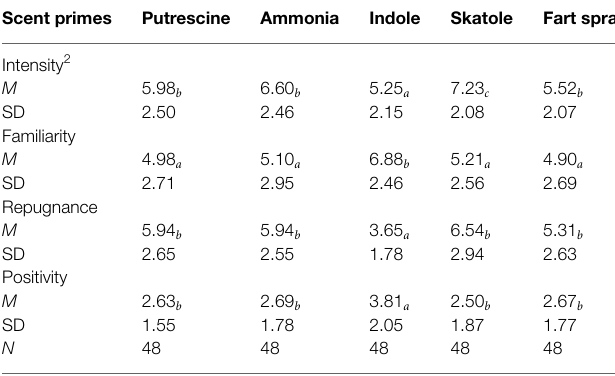
TABLE 1 | Hedonic evaluations of putrescine, ammonia, indole, “fart spray,” and skatole 1 (Pilot study). Scent